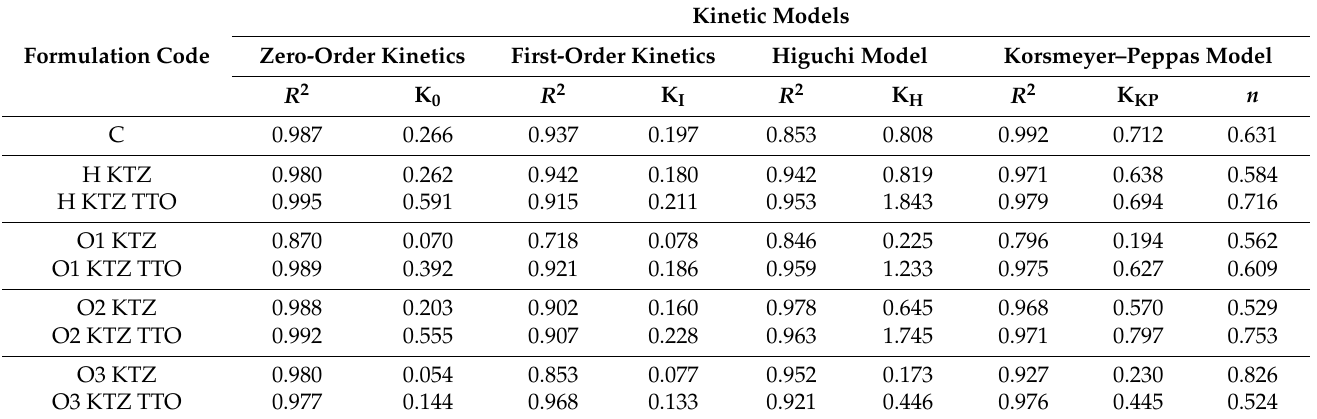
Table 5. Models of KTZ release from designed formulations and commercially available product